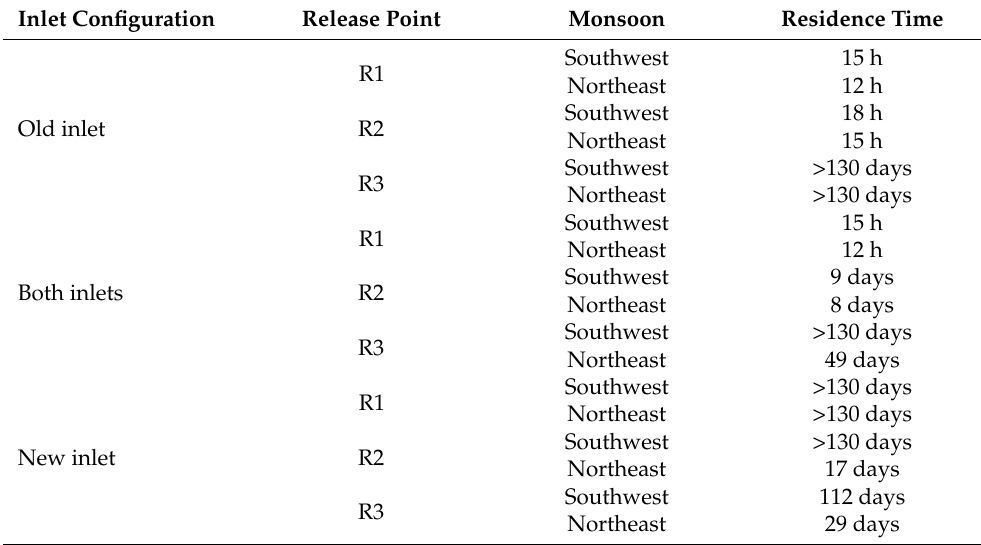
Table 4. Residence time estimated at different release points under different inlet configurations in the Setiu Lagoon during the southwest and northeast